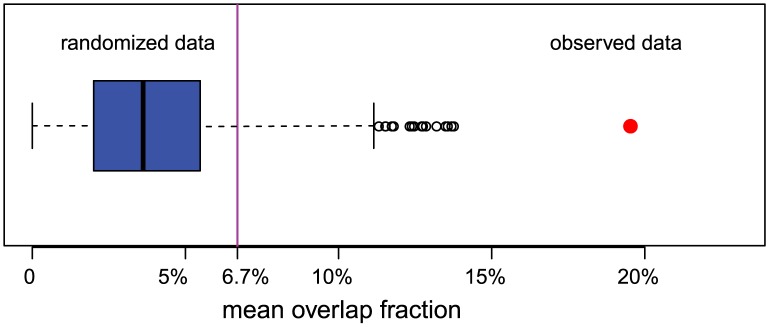
Studies agree substantially at the level of functional categories.When each study's confirmed gene list is processed for enriched functional categories from GO (Gene Ontology), substantially more categories are identified in multiple studies than one would expect by chance, suggesting a positive association in functional signals underlying the study-specific gene lists. Shown is the distribution of an agreement statistic (mean overlap fraction) generated by gene-permutation, where the multi-functional analyzer (MFA) approach is applied to every gene list to produce a list of over-represented GO terms. The actual agreement between studies (red) is strikingly higher than expected by chance (blue) and also much higher than the 6.7% gene-list agreement (purple).